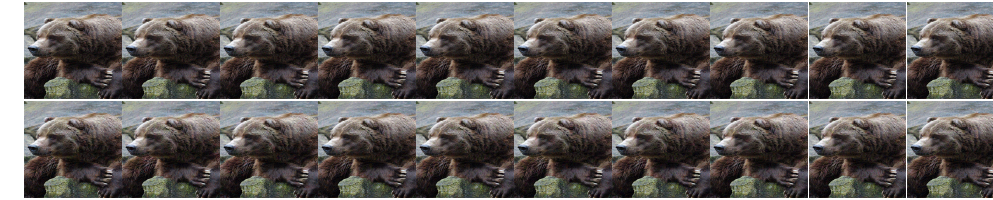
( A 4 ) stemming from the A 4 5 k